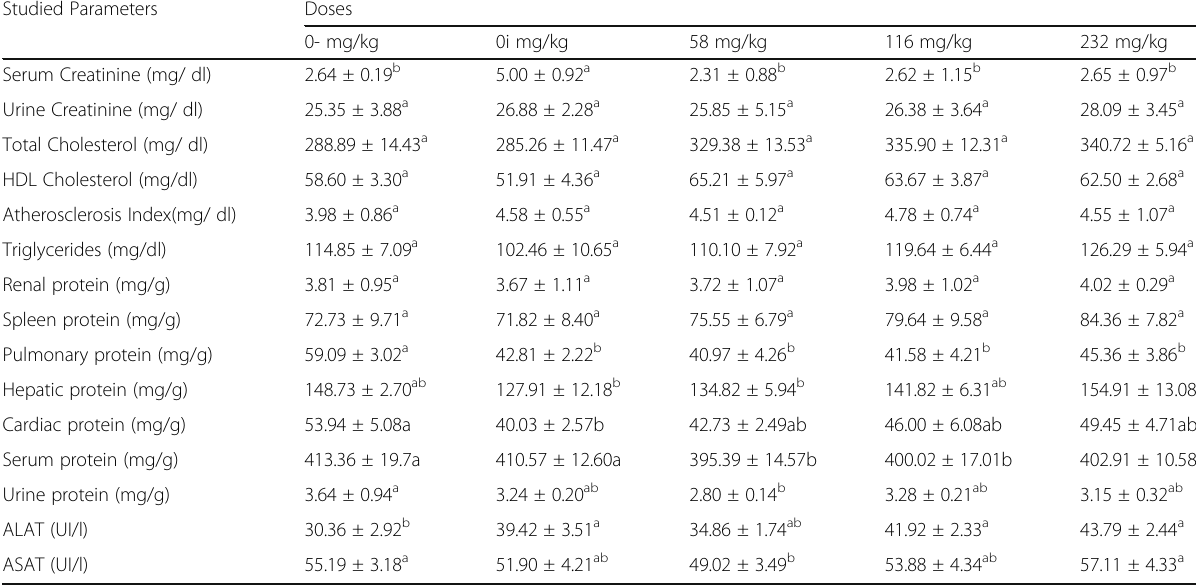
Table 8 Effects of doses of aqueous extract from A.cordifolia on biochemical parameters after 2 weeks of administration to rats Studied Parameters